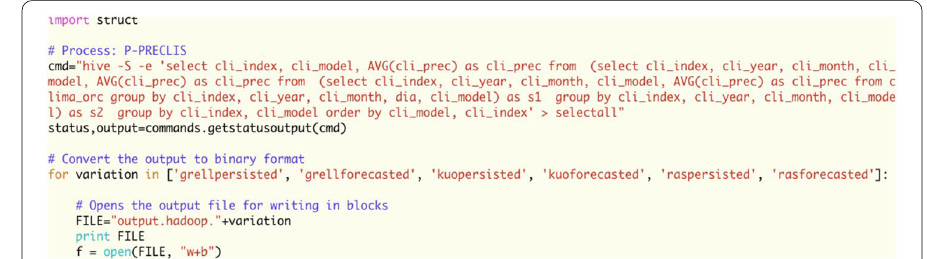
Fig. 16 A Python language fragment of code for a seasonal climate